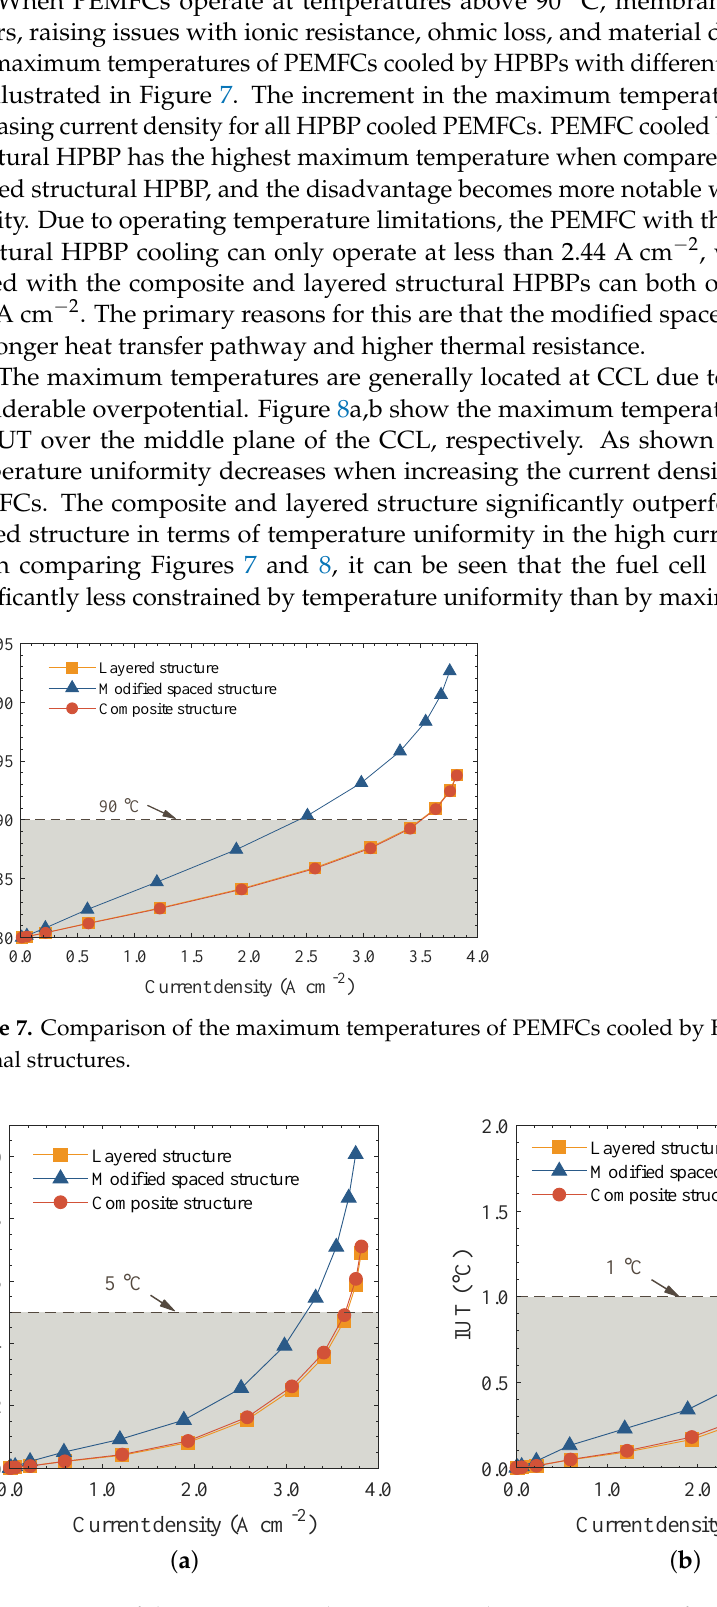
Figure 8. Impact of the HPBP internal structures on the temperature uniformity over the middle plane of the CCL: ( a ) Maximum temperature difference. ( b ) Index of uniform